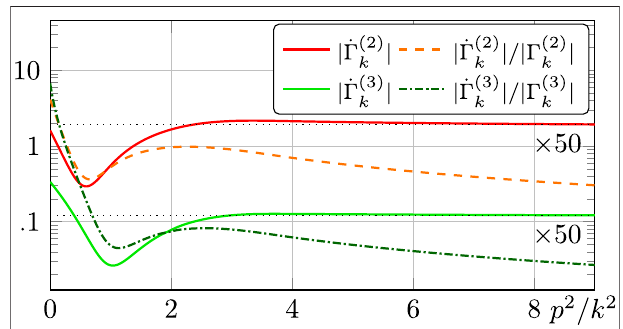
FIGURE 5 | Displayed are the fl ows of the traceless transverse parts of (cid:17)(cid:17)(cid:17)(cid:17)(cid:17) (cid:17)(cid:17)(cid:17)(cid:17)(cid:17) (cid:17)(cid:17)(cid:17)(cid:17)(cid:17) (cid:17)(cid:17)(cid:17)(cid:17)(cid:17) Γ ( 2 ) Γ ( 3 ) z z the graviton two- and three-point functions, and , as a function t t k k of dimensionless momentum. The fl ows approach constants for large momenta, and they do not grow with p 2 as expected from a naive counting of momenta. The fl ows are normalized by the respective n -point (cid:17)(cid:17)(cid:17)(cid:17)(cid:17) (cid:17)(cid:17)(cid:17)(cid:17)(cid:17) (cid:17)(cid:17)(cid:17)(cid:17)(cid:17) (cid:17)(cid:17)(cid:17)(cid:17)(cid:17) (cid:17)(cid:17)(cid:17)(cid:17)(cid:17) (cid:17)(cid:17)(cid:17)(cid:17)(cid:17) (cid:17)(cid:17)(cid:17)(cid:17)(cid:17) (cid:17)(cid:17)(cid:17)(cid:17)(cid:17) Γ ( 2 ) Γ ( 3 ) z / / Γ ( 2 ) z Γ ( 3 ) functions, and . These ratios tend toward zero for t t k k k k largemomentawhichsignalsmomentumlocality.The fi